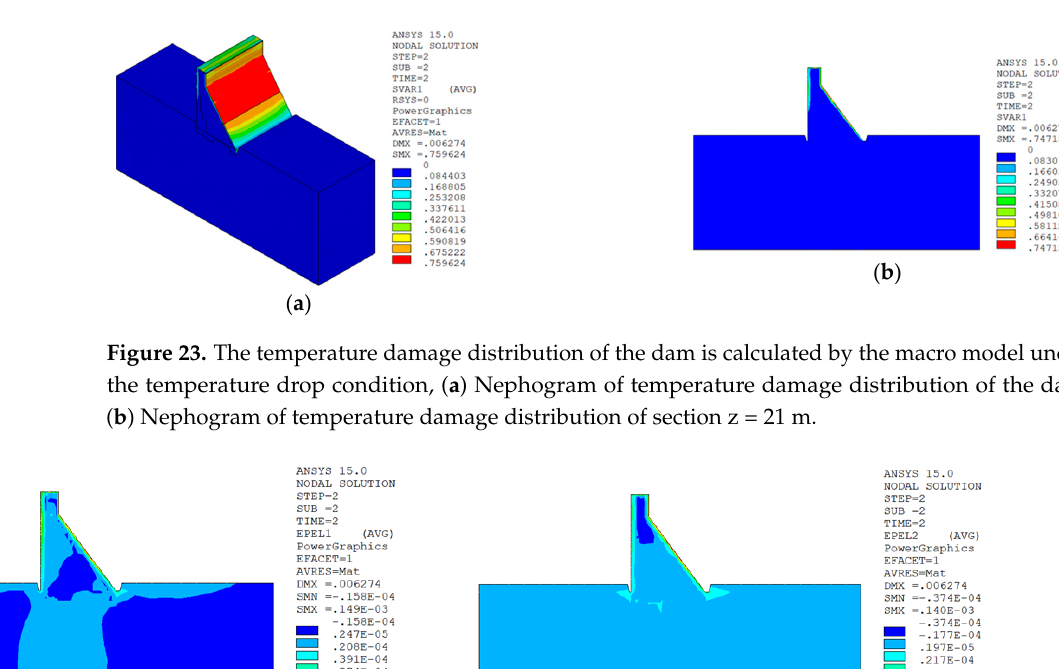
lated by the macro model is shown in Figure 23.